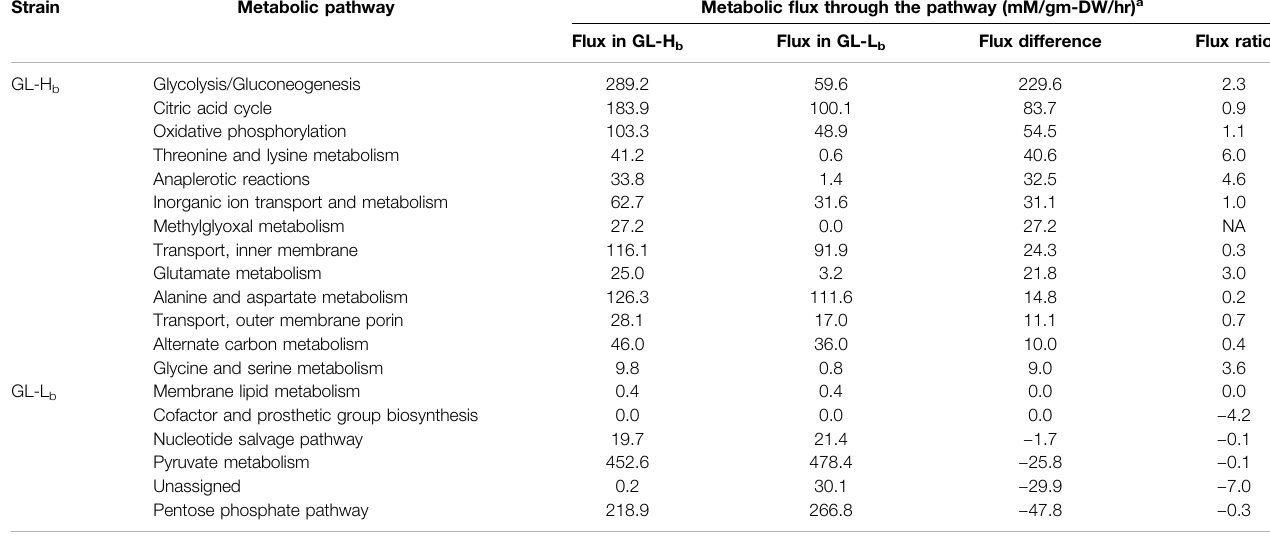
TABLE 3 | Cumulative metabolic fl ux through major pathways in simulated GL-L b and GL-H b strains as obtained through Flux Balance Analysis. Log two fold-change of fl uxes of GL-H b and GL-L b are indicated in the Flux Ratio